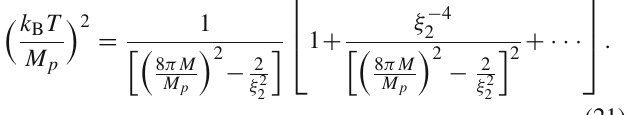
From C to B: S rem increased with ξ 2 . From B to : S rem decreasedwith ξ 2 . A: The Maximum Value of S rem .